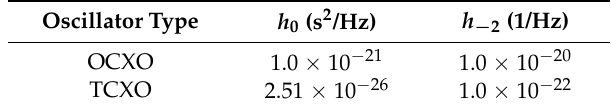
Table 1. Coefficients for oven-controlled crystal oscillator (OCXO) and temperature compensated crystal oscillator